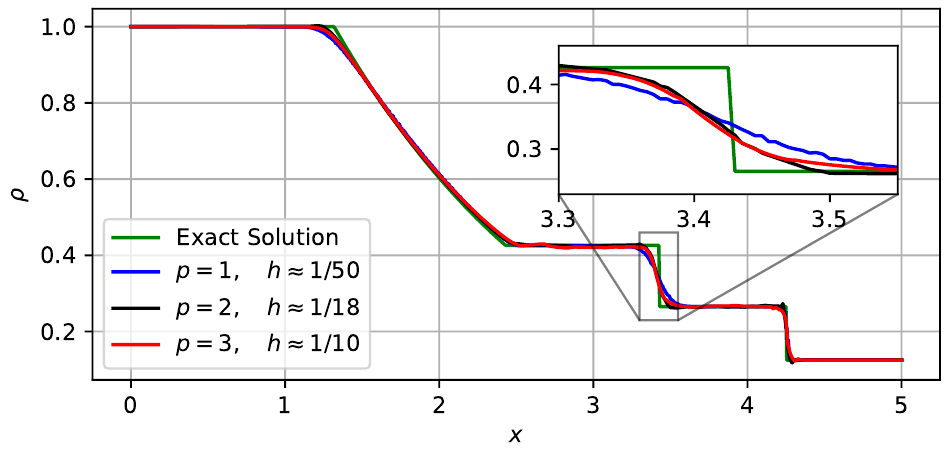
Figure 3. Comparison between solutions given by various h – p pairs.